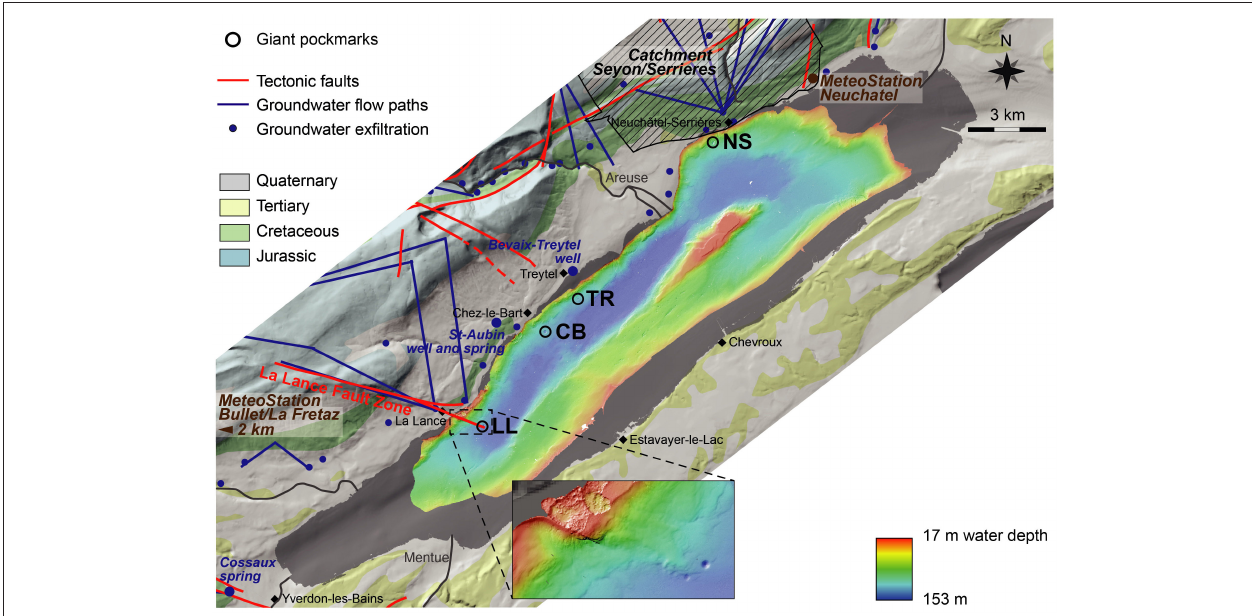
FIGURE 1 | Lake Neuchatel with Swath bathymetry below 17m water depth (Reusch, 2016), as well as with the locations of the four giant pockmarks along the northern shore (LL, CB, TR, NS) and of springs and wells used as comparison for water parameters. The main geological units, tectonic faults, and some well-known groundwater flow paths and groundwater infiltration points are also shown (Swisstopo, 2014).